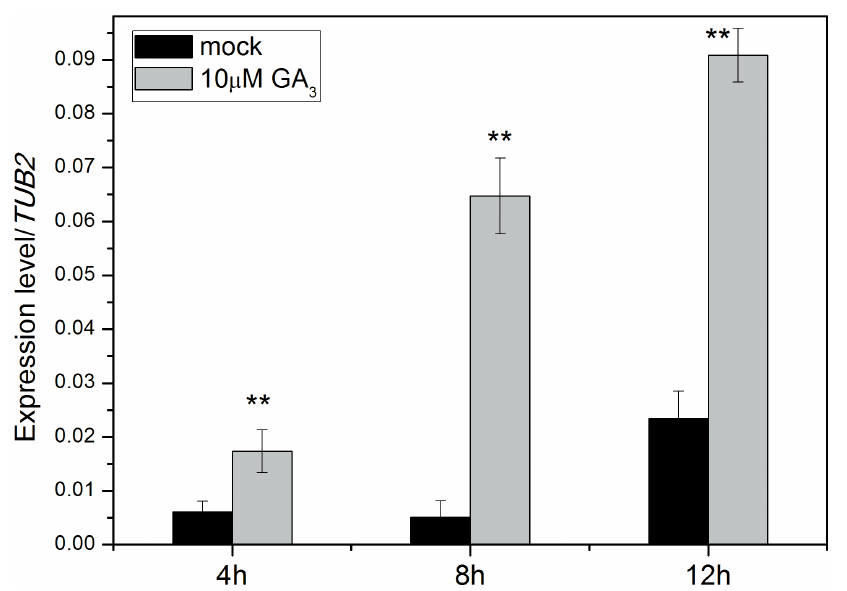
Figure 4. Expression of AtEXP2 in response to exogenous GA application. Col-0 wild type seeds were harvested 4 h, 6 h and 8 h after imbibition in 10 m M GA 3 solution for RNA extraction respectively. Transcript levels were measured by real-time RT-PCR, and the values were normalized against the levels of TUB2 as a control. Error bars represent SD. A Student’s t-test was calculated at the probability of 1% (**P , 0.01).